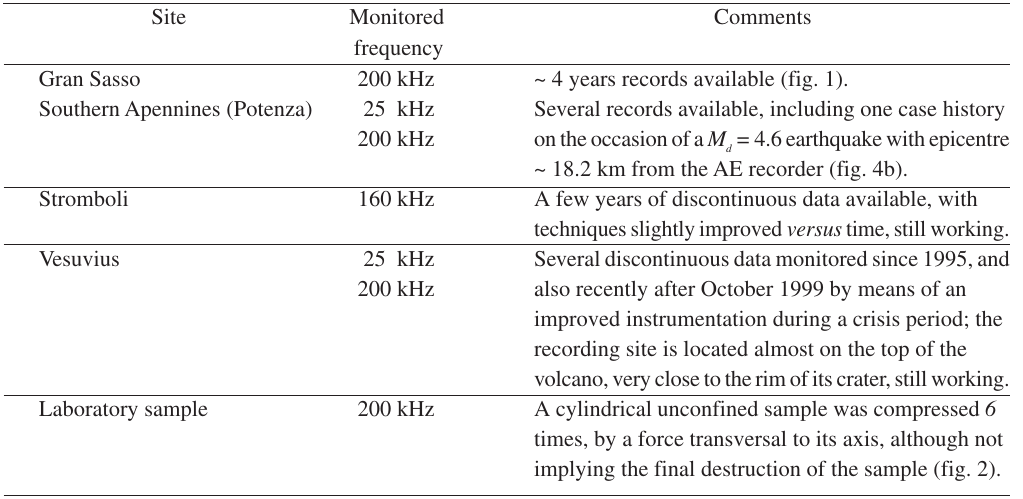
Table I. The AE data